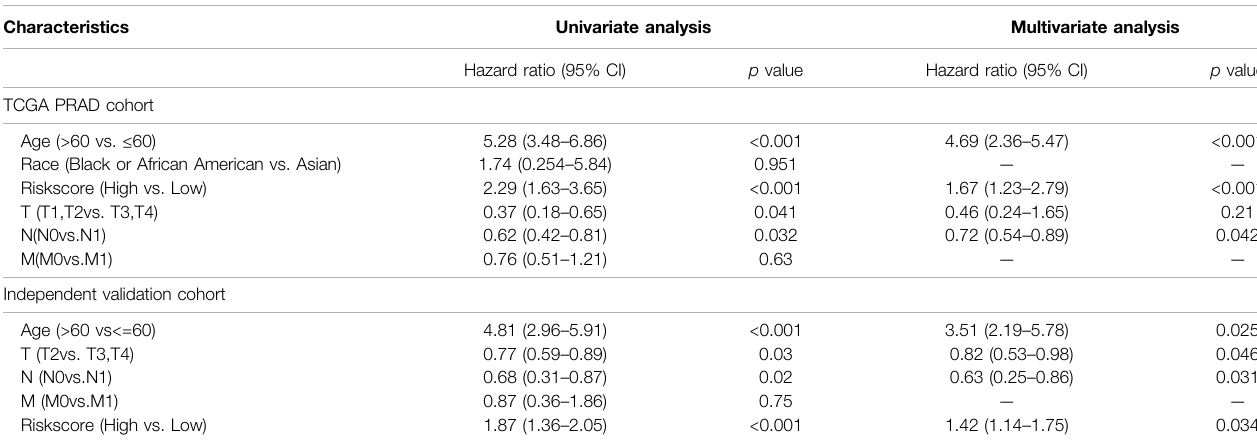
TABLE 3 | univariate cox and multivariate cox regression analyses.